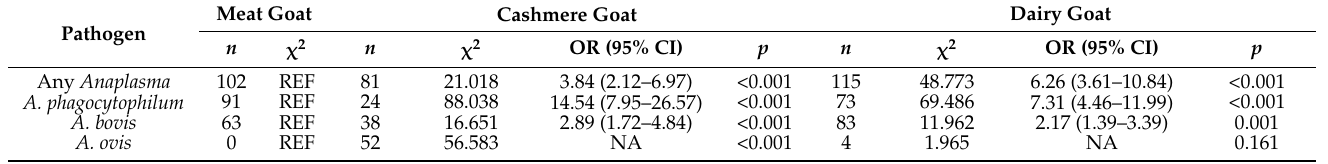
Table 4. Differences in the occurrence of Anaplasma in each production categories of goats in the present study, as indicated by results of chi-square